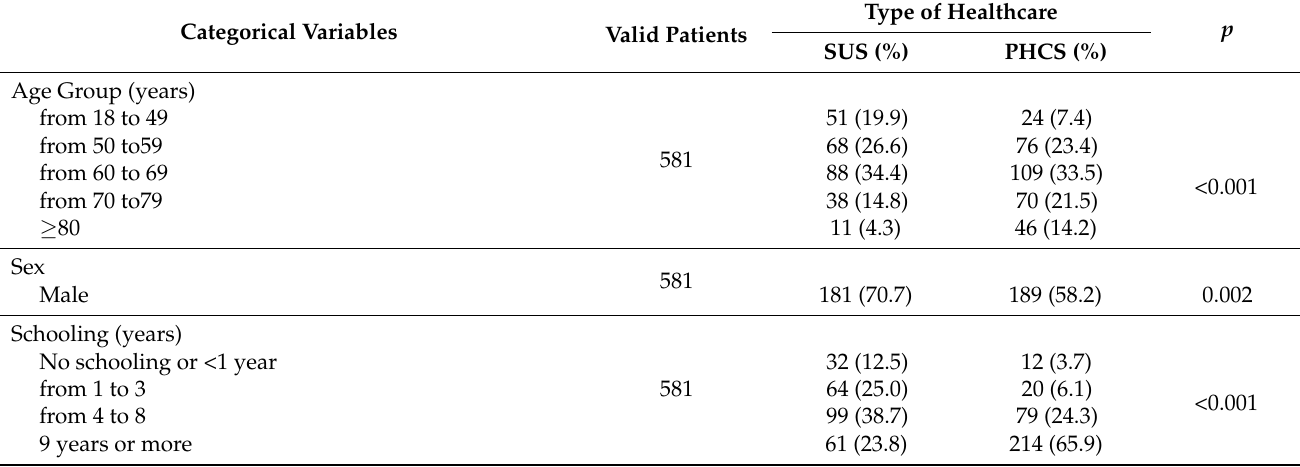
Table 1. Baseline characteristics, cardiovascular outcomes, and adherence to secondary prevention (adherence to physical activity, medication, smoking cessation, and diet quality) in patients with ACS, according to the Type of Healthcare, Aracaju,